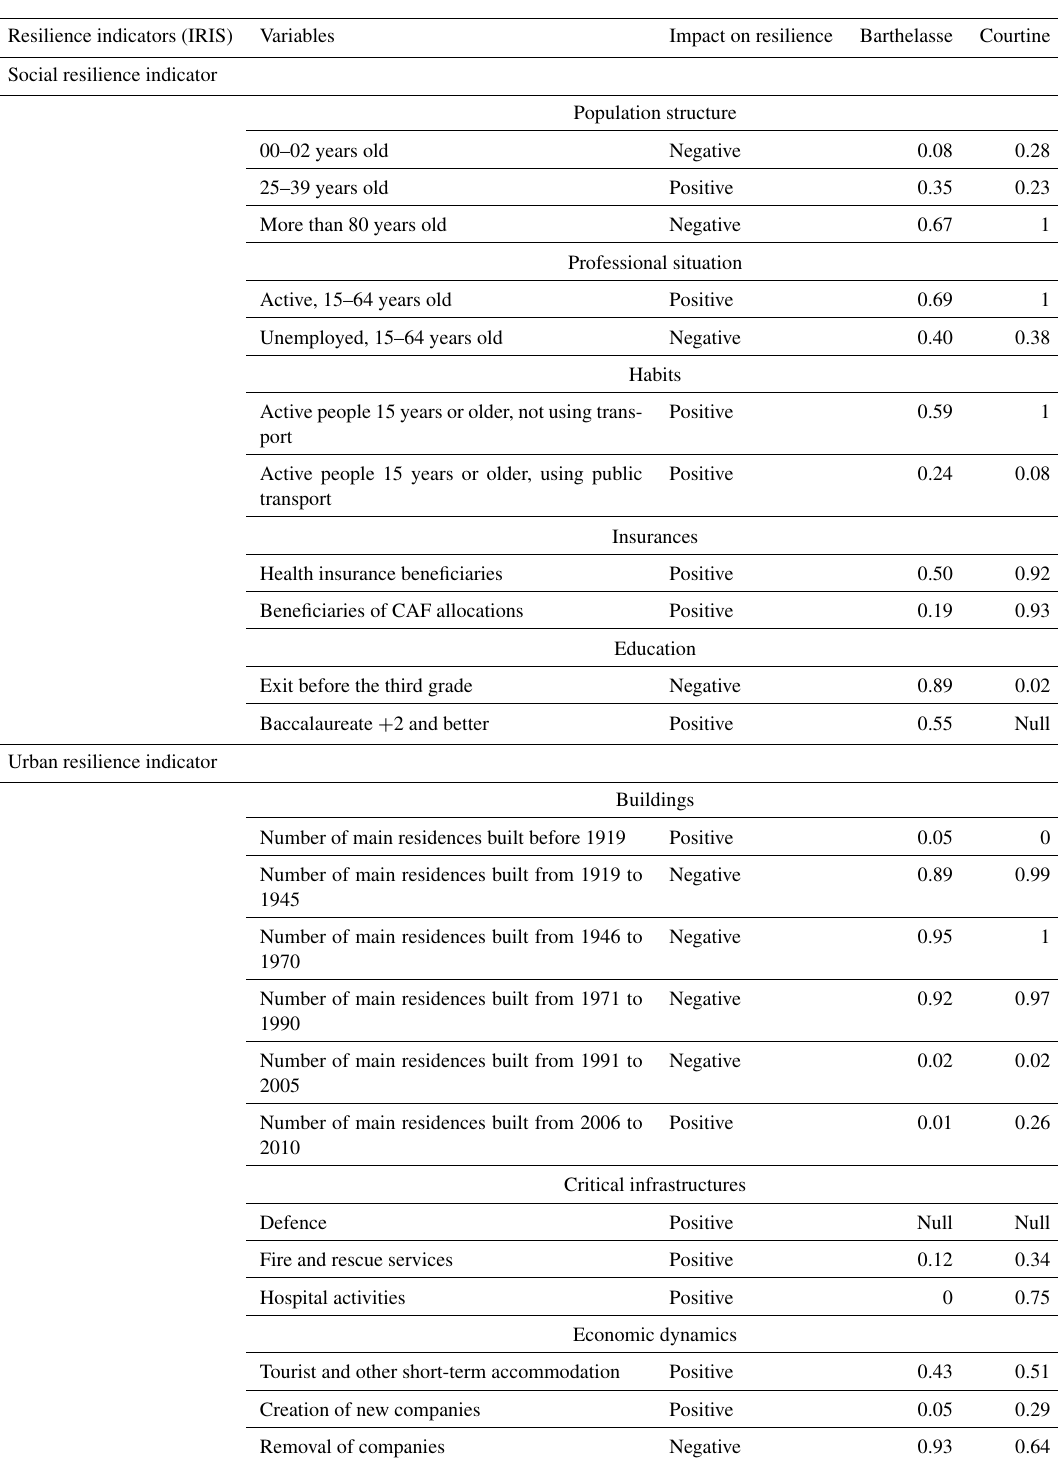
Table 2. Variable values – scenario before